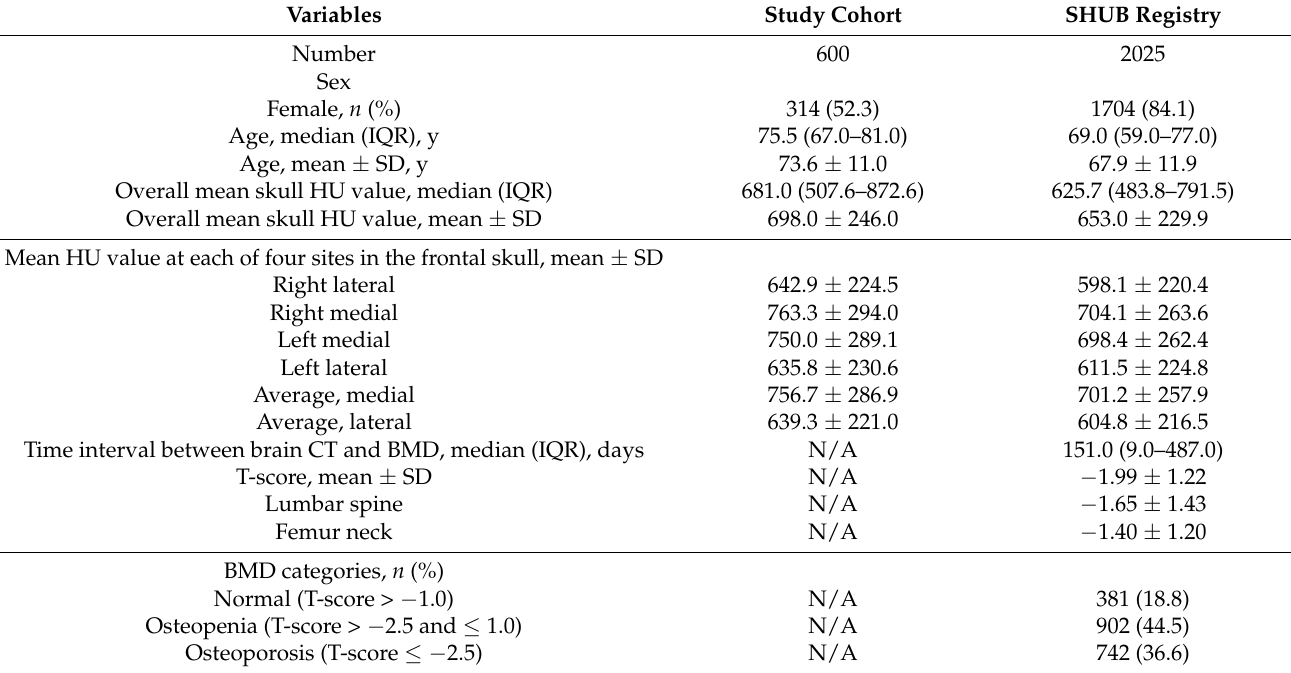
Table 2. Descriptive information about skull HU values and BMD in the study and SHUB registry